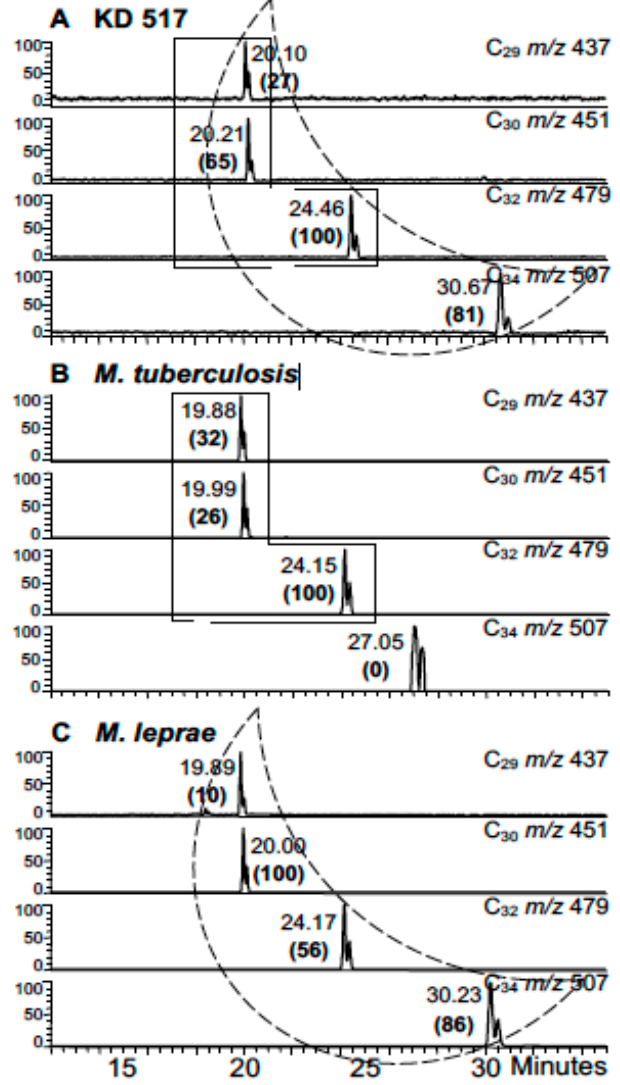
Figure 9. Mycocerosic acid GC-MS profiles from extracts of KD 517 [13] A . KD 517. B . M. tuberculosis . C . M. leprae . Comments: Good mycocerosate profile has M. leprae- specific C 34 mycocerosate; a search for mycolipenate might have helped confirm MTB. The C 34 component at 27.05 minutes in the M. tuberculosis standard ( B ) is not a mycocerosate. Verdict: Mycocerosates confirm some leprosy, but mycolate profiles (Figure 8) show predominance of MTB.